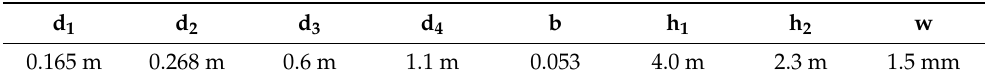
Figure 1. ( a ) The geometry setup of the numerical simulations. ( b ) The fan, stationary inlet duct, and gap between them. Red indicates the gap. The fan rotates about the x -axis. Table 1. The key parameters of the voluteless fan.